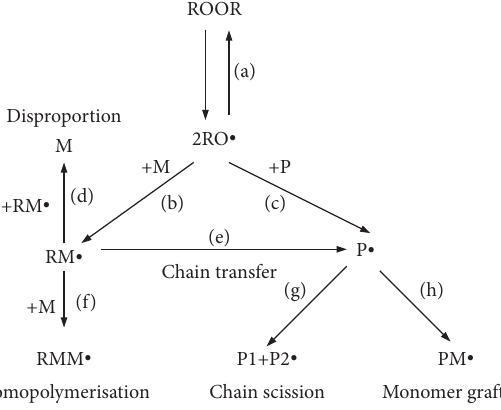
Figure 2: A simplified reaction scheme of the PP-g-MAH grafting